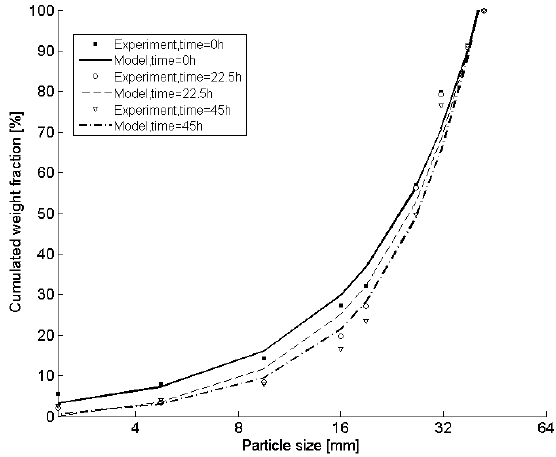
Figure 7. Worn liner causes the size distribution curve to change over time.